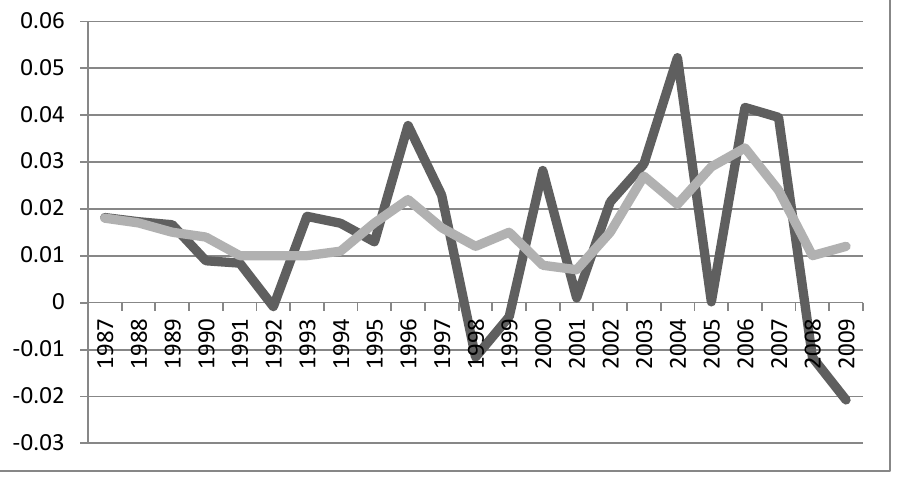
FIGURE 1: Graphically depicting White’s Law for the energy produced in South Africa, the dashed line using year on year data, and the solid line using a four-year moving average between 1987 and 2009 Source: Data derived from World Bank